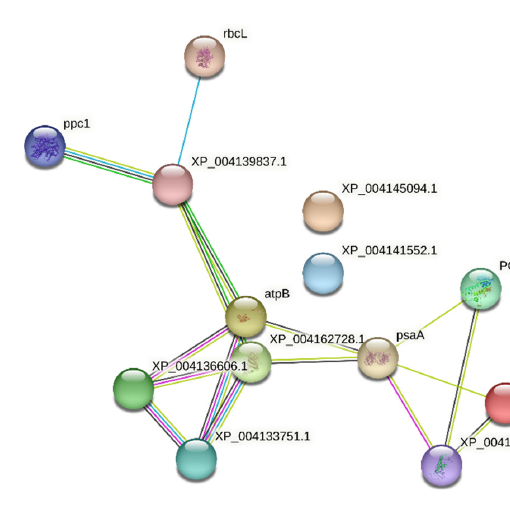
( c ) Figure 12 . STRING analysis of (a) more abundant; (b) less abundant and (c) gene co-occurrence patterns across genomes shows similarities